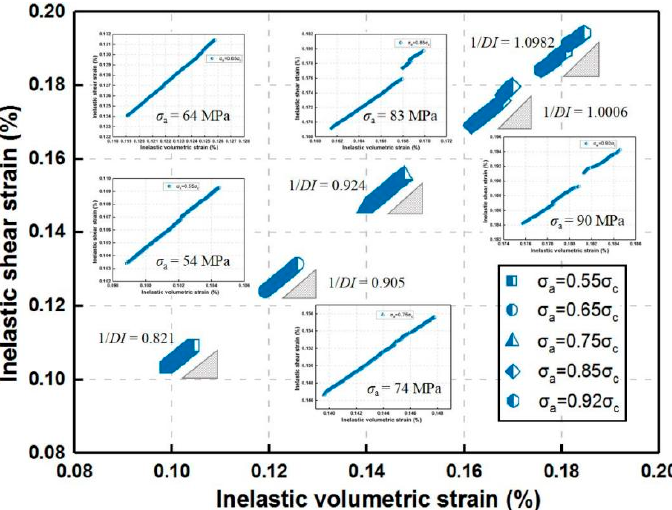
Figure 14. Strain path in inelastic shear strain vs. volumetric strain space for the constant homogene-